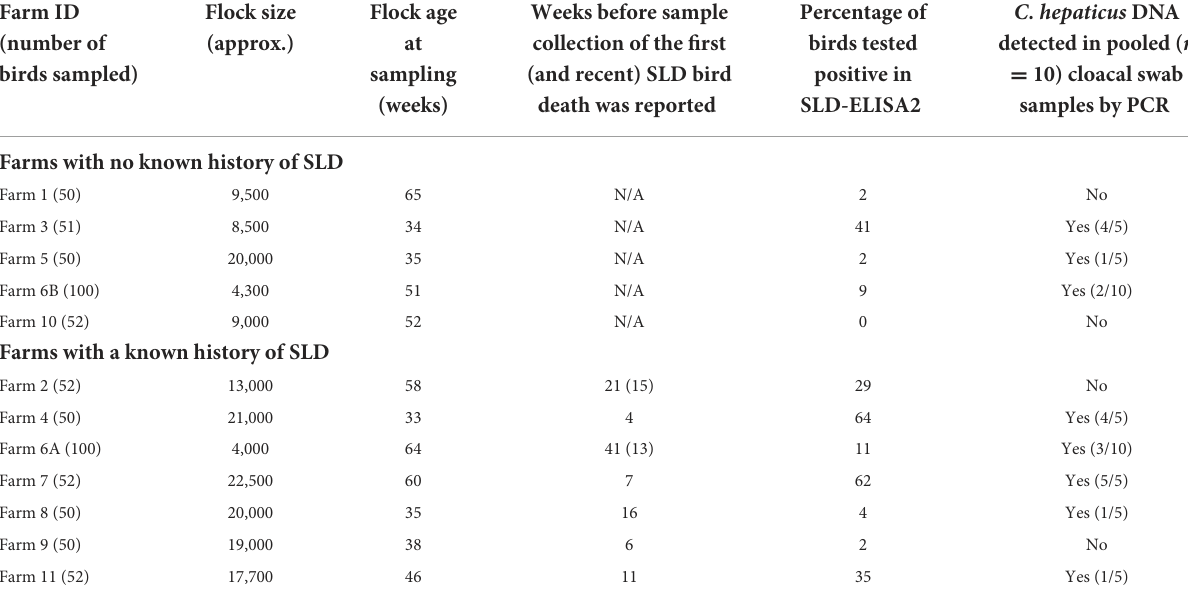
TABLE 1 Prevalence of anti- Campylobacter hepaticus antibodies and C. hepaticus DNA among Australian free-range layers. Farm ID Flock size